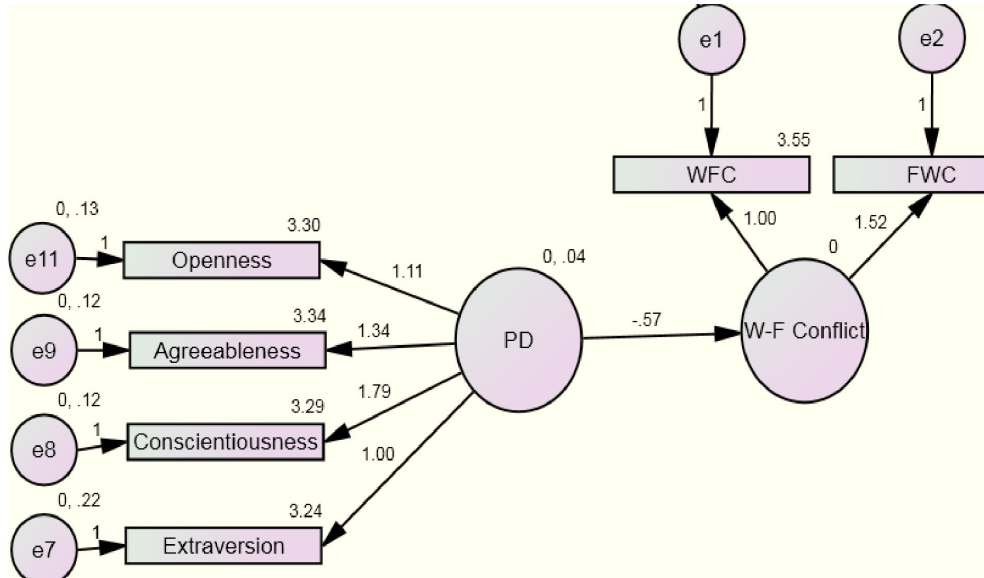
Figure 4. Showing the estimates extracted by running Structural Equation Modeling to predict W-F Conflict by personality